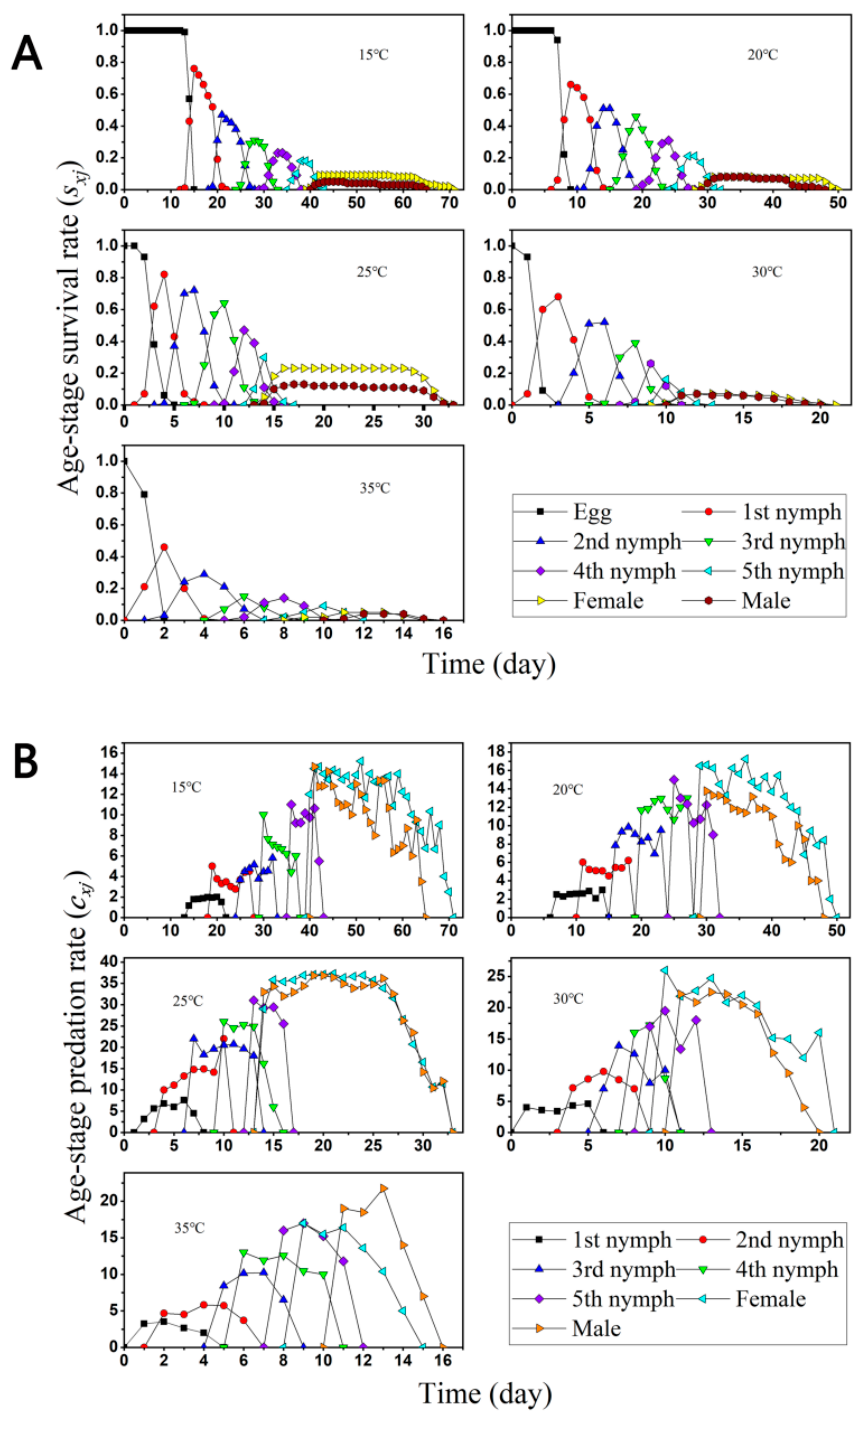
Figure 1. Age-stage specific survival rate ( s xj ) ( A ) and age-stage specific predation rate ( c xj ). ( B ) of O. minutus starting from 100 eggs fed on D. minowai at different temperatures.